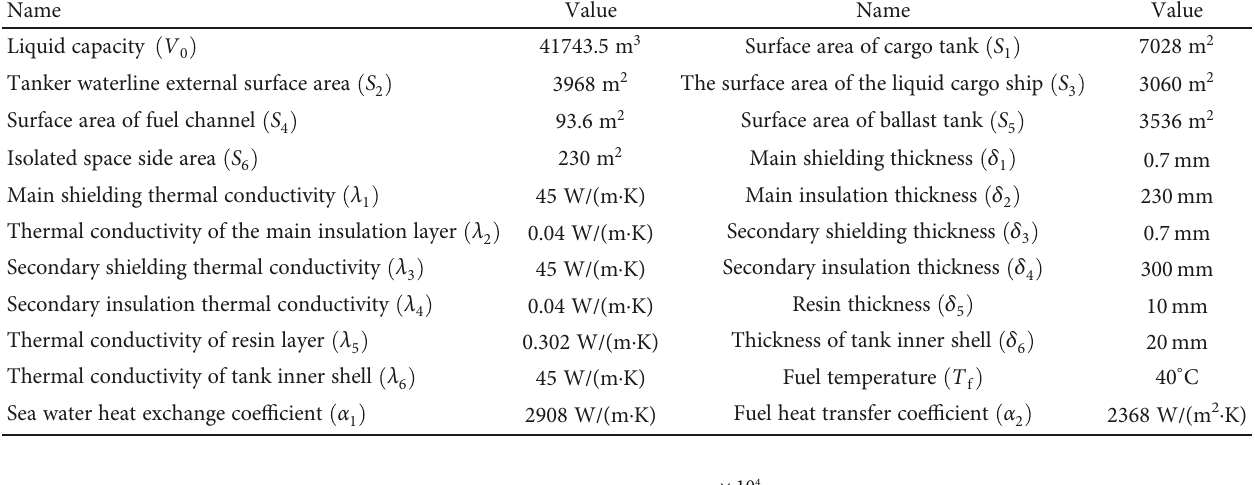
Table 2: Parameters of liquid cargo tanks for thermal load